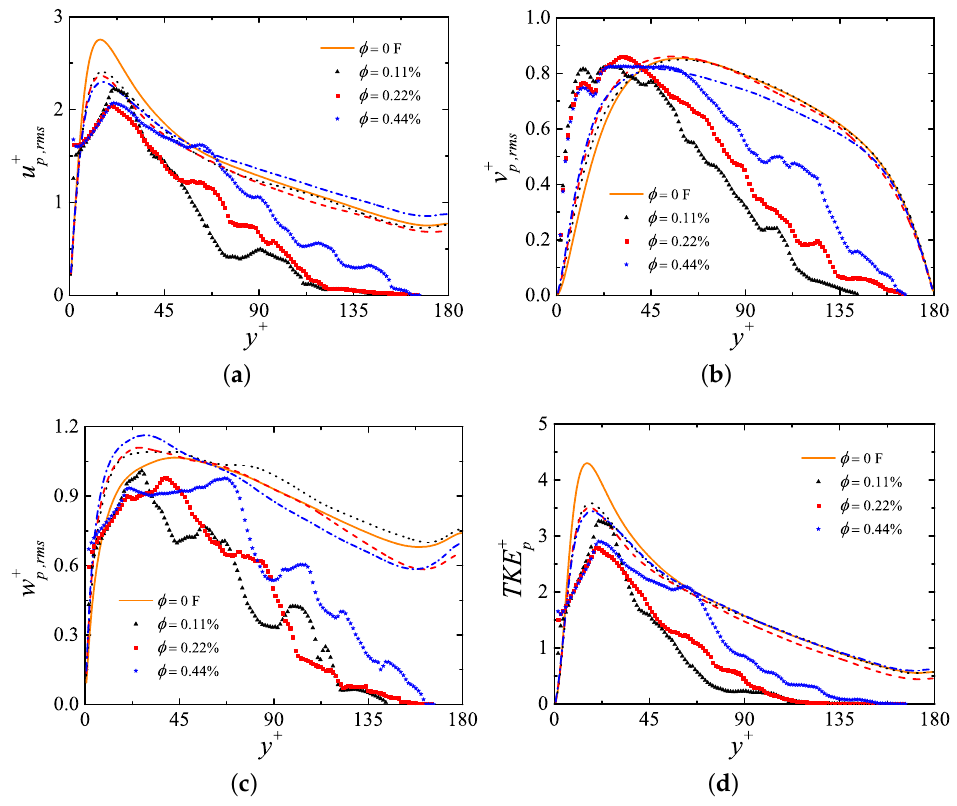
Figure 10. ( a – c ) Intensities of the particle RMS velocity fluctuations in the streamwise, wall-normal, and spanwise directions, respectively, and ( d ) particle turbulent kinetic energy (TKE). The corre- sponding profiles of the fluid phase are also shown for comparison